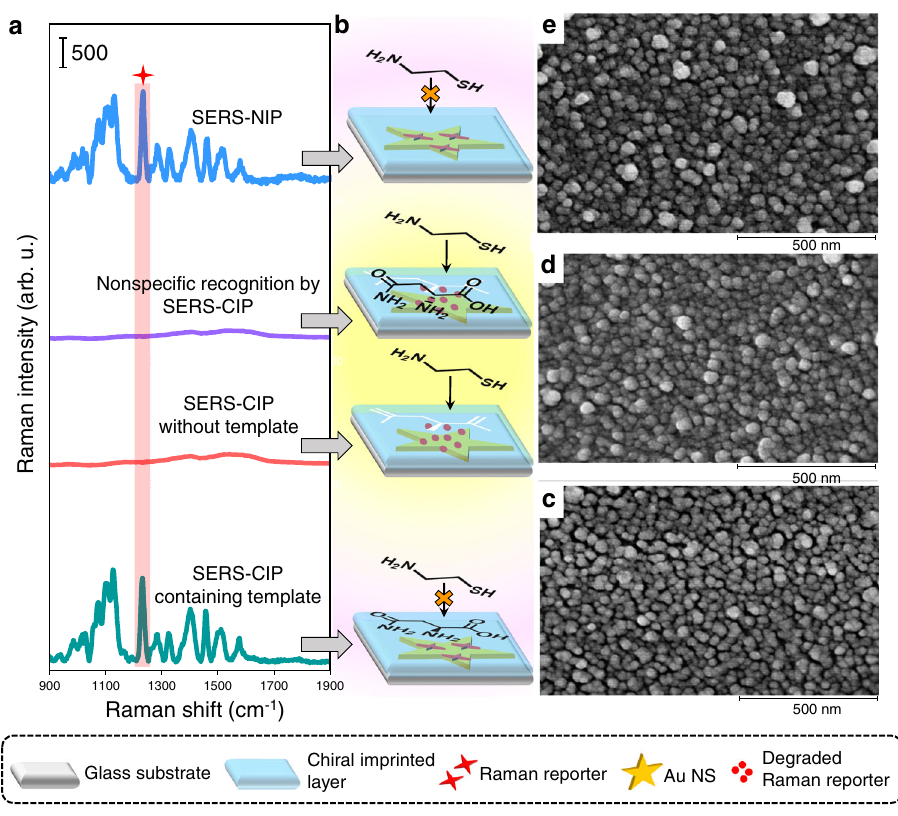
Fig. 4 | Implementation of the IRM on SERS-CIP. a Raman spectra of DTTC on differentplatforms,and b correspondingplatformstatuses.SEMimagesof c SERS- CIP containing a D -asparagine template, d SERS-CIP without a d-asparagine